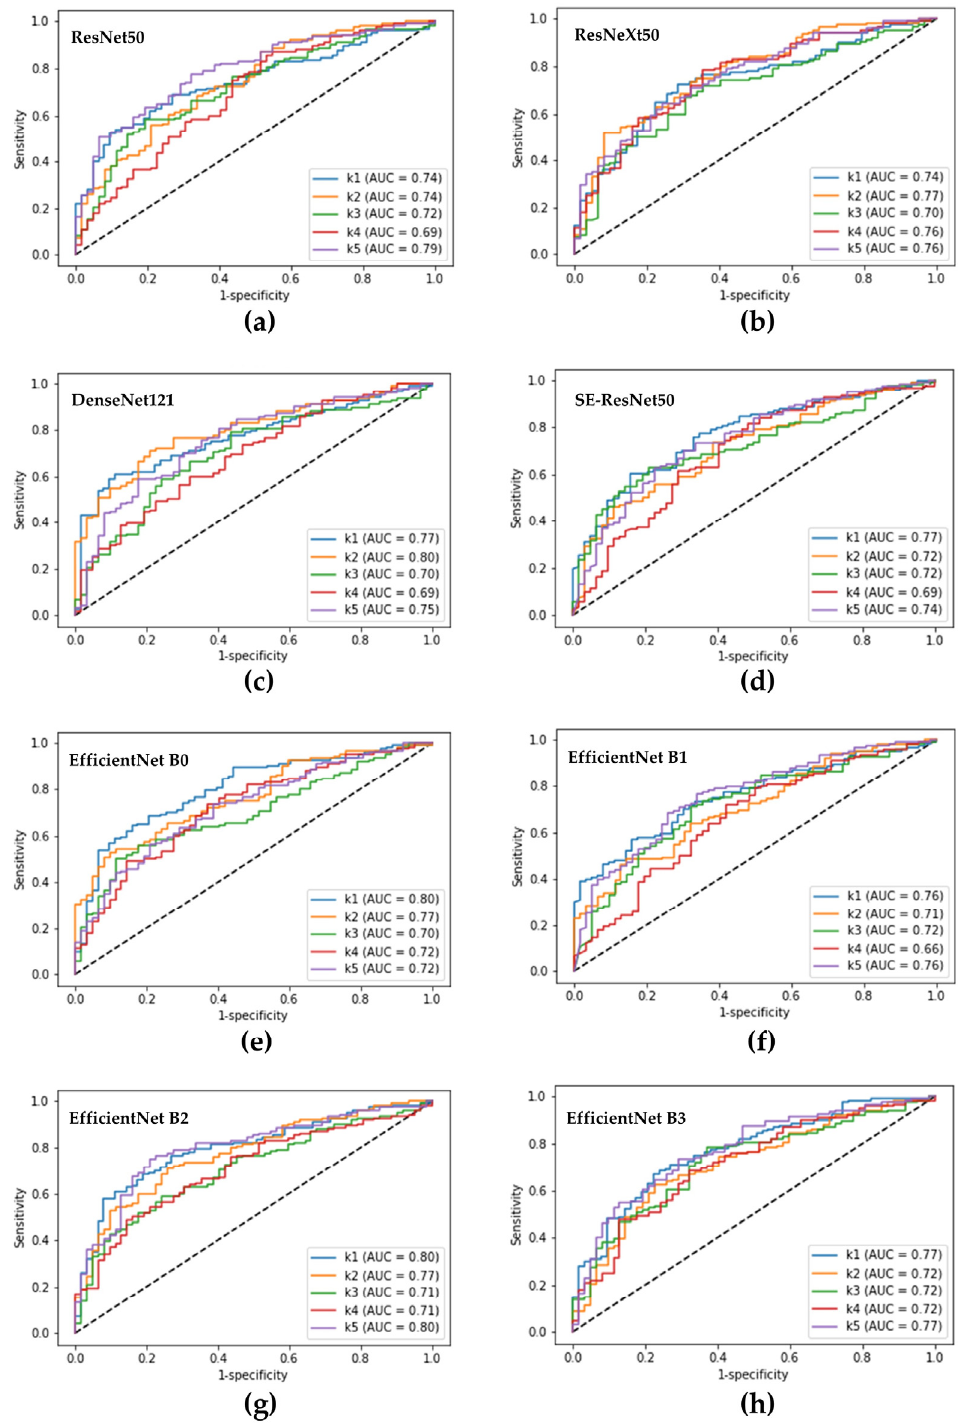
Figure 3. Receiver operating characteristic curves obtained from the fivefold cross-validation of the single deep learning models for distinguishing pseudomonas keratitis from other forms of bacterial keratitis. ( a ) Receiver operating characteristic (ROC) curves of the ResNet50 model; ( b ) ROC curves of the ResNeXt50 model; ( c ) ROC curves of the DenseNet121 model; ( d ) ROC curves of the SE-ResNet50 model; ( e – h ) ROC curves of the EfficientNets B0, B1, B2, B3 models, respectively. k1 to k5 represent the obtained ROC curves from the five test results of fivefold cross-validation. AUC, the area under the ROC curve.